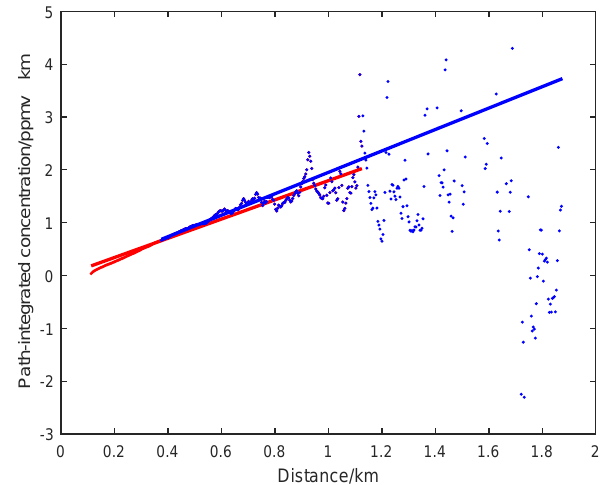
Figure 8. Values of the mean square error for (left) different values of α with β = β 0 , and (right) different values of β with α = α 0 , corresponding to GLS fits to data with indices m E to m HGH . The vertical dashed lines in the two graphs correspond, respectively, to the values α 0 and β 0 .